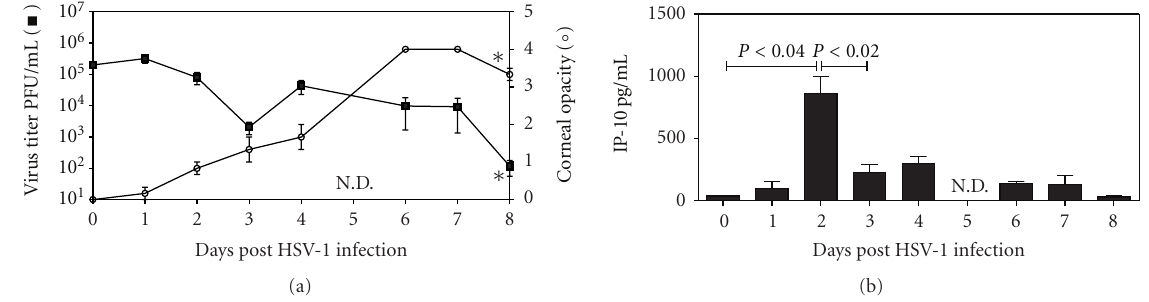
Figure 3: IP-10 is produced at significant levels in the HSV-1 infected cornea. Mice were infected with 2 × 10 5 PFU HSV-1 on the scarified cornea. Mice were monitored for corneal opacity (graph (a), open circle, ◦ ) an asterisk indicates a significant increase between day 1 and 8. At the indicated time points corneas ( n = 3) were excised and lysates produced for virus titration (graph (a), closed box, (cid:2) ), an asterisk indicates a significant reduction from day 1 to day 8 ( t -test) and the medians for the data are found to be significantly di ff erent by a nonparametric test (Kruskal-Wallis test). Levels of IP-10 protein production within the infected corneal lysates are shown in (b). N.D. = not done.